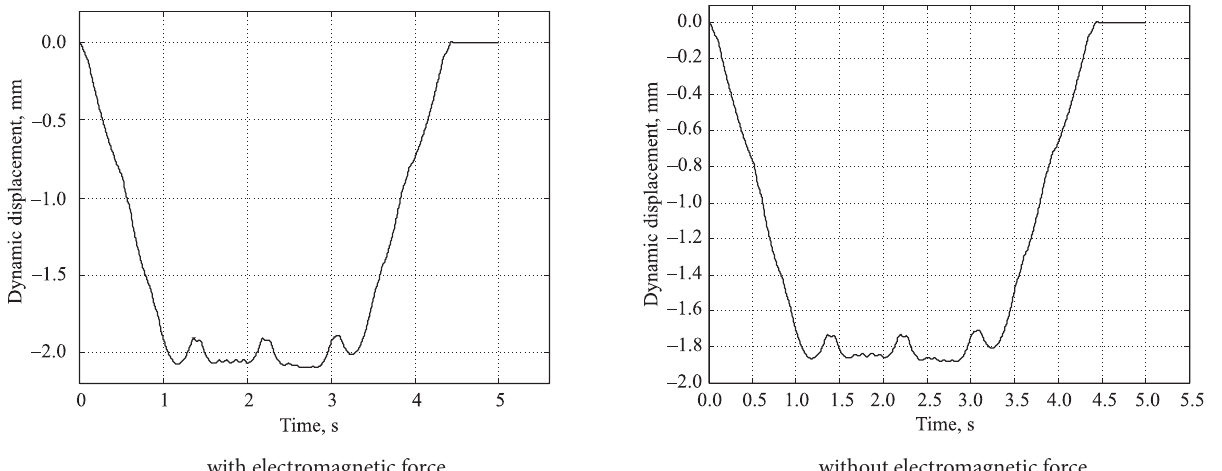
Fig. 4. Calculated dynamic displacement time-histories of 30 m simply supported bridge for velocity 80